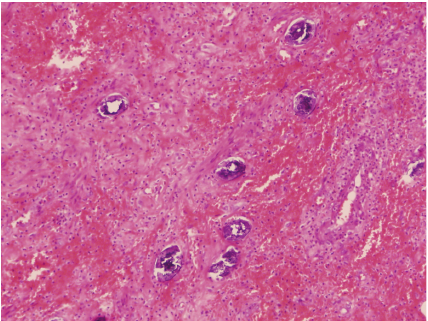
Figure 3: Para ffi n embedded 5 µ m thick section of appendiceal wall, process from the patient appendix. Magnified image by Light microscopy × 350 and stained with H-E. Can be seen S. Mansoni eggs penetrating the appendiceal wall surrounded by heavy haemorraghic